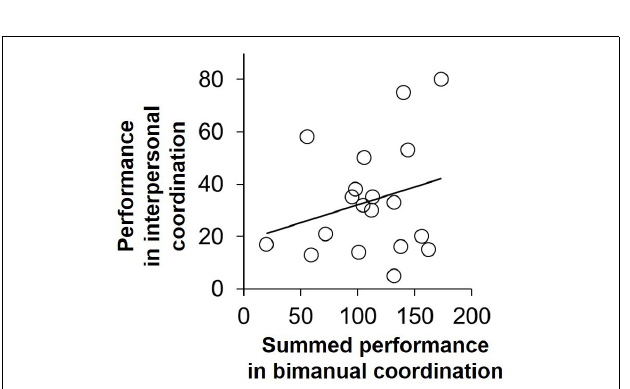
FIGURE 4 | The scatter plot between summed performance value in the bimanual coordination task and the performance value in IMC. The Pearson product-moment correlation of these two variables was not significant ( r = 0.25, p =